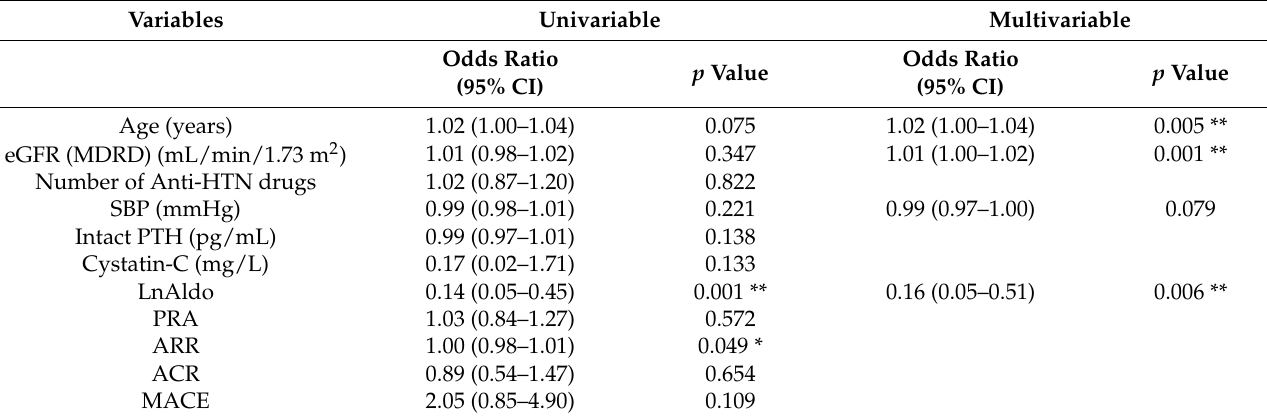
Table 2. Univariable and multivariable logistic regression analysis of associated clinical and biochemical factors for GRA